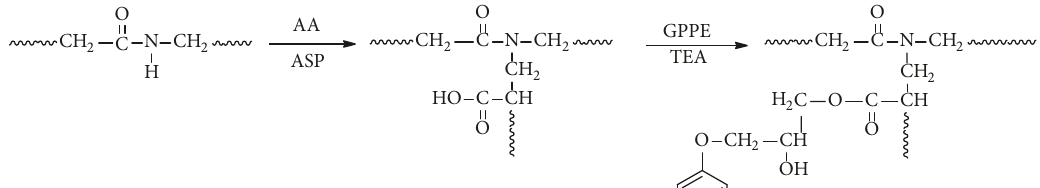
Figure 3: Grafting mechanism.